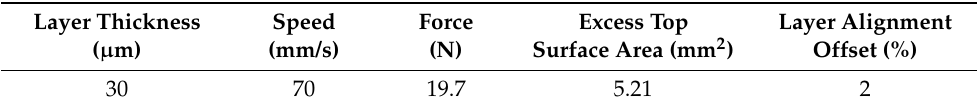
Table 3. Confirmation of predicted SAM settings.